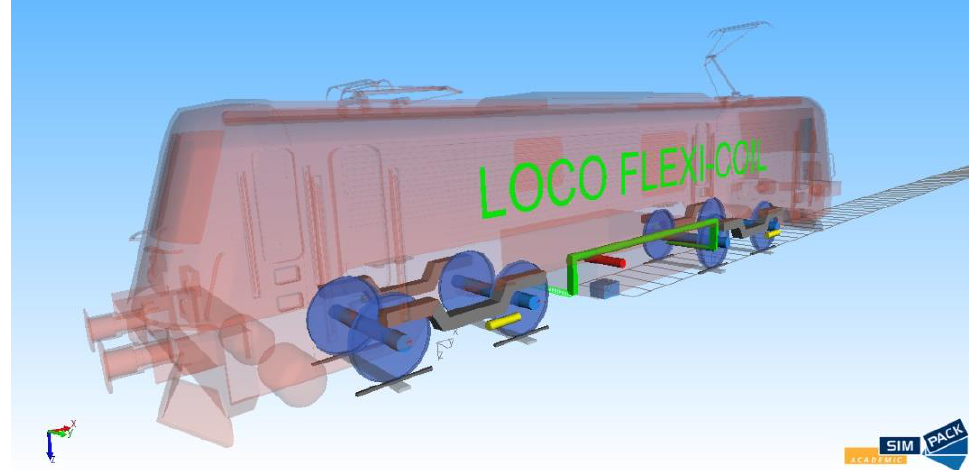
Figure 2. Graphical representation of the simulation model. Table 1. Main parameters of the simulation model.